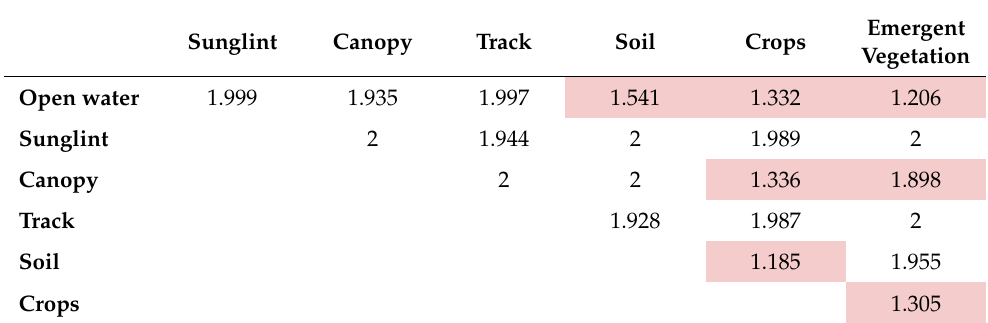
Table 2. Summary of Jeffries-Matusita distance scores as a measure of spectral separability between land cover classes, where a distance score of 2 is perfect separability and values < 1.9 (coloured in red) represent spectral confusion between